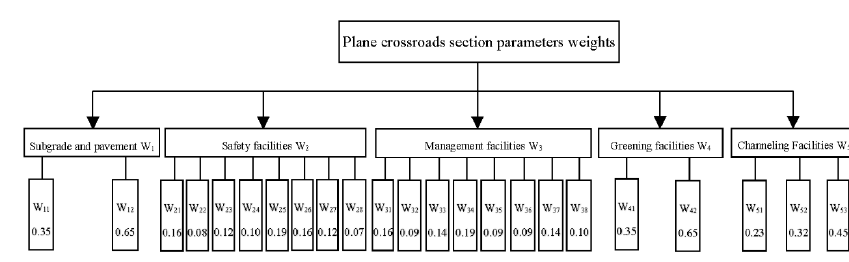
Fig. 3 Summary of plane crossroads section parameters